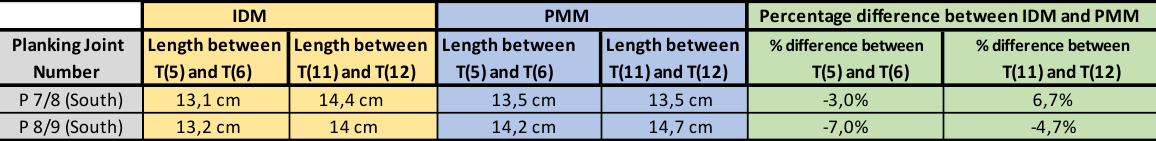
Table 1. Measurements distances between different tenons on the planking joints P7/8 and P8/9. T stands for “tenon”. In yellow, the interpretative drawn measurements (IDM). In blue, the photogrammetry model measurements (PMM). In green, the percentage difference between the ISIDM and the PMM. The total margin of error of the percentage difference between the IDM and the PMM for the length between the measurements of tenons 5 and 6 and tenons 11 and 12 is of 5.3%.